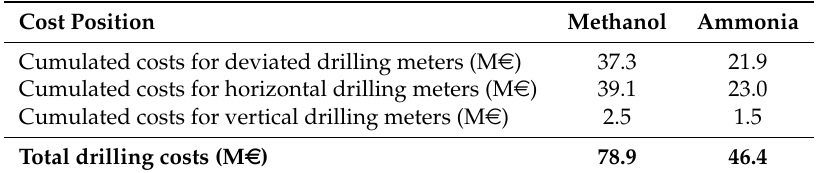
Table 7. Drilling costs in the offshore methanol and ammonia production